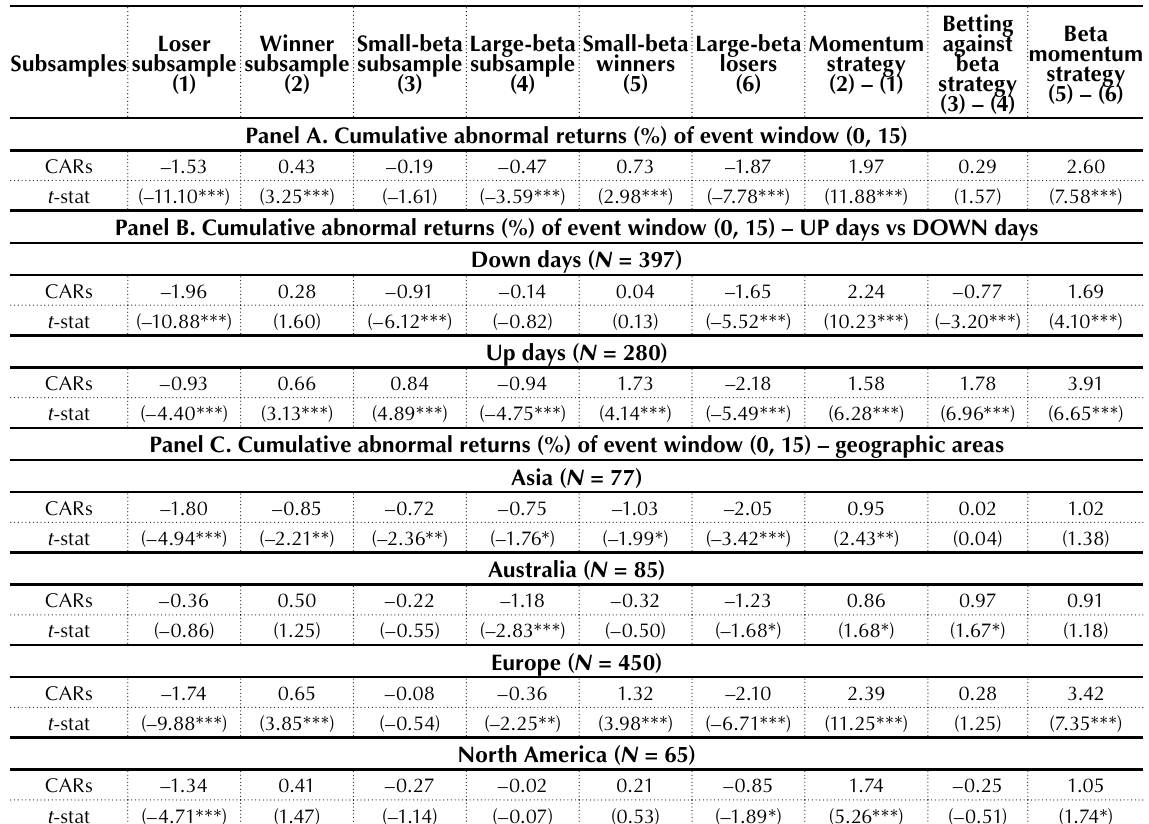
Table 7. Cumulative abnormal returns (CARs) after extreme market movements using 2 percent cut- off point